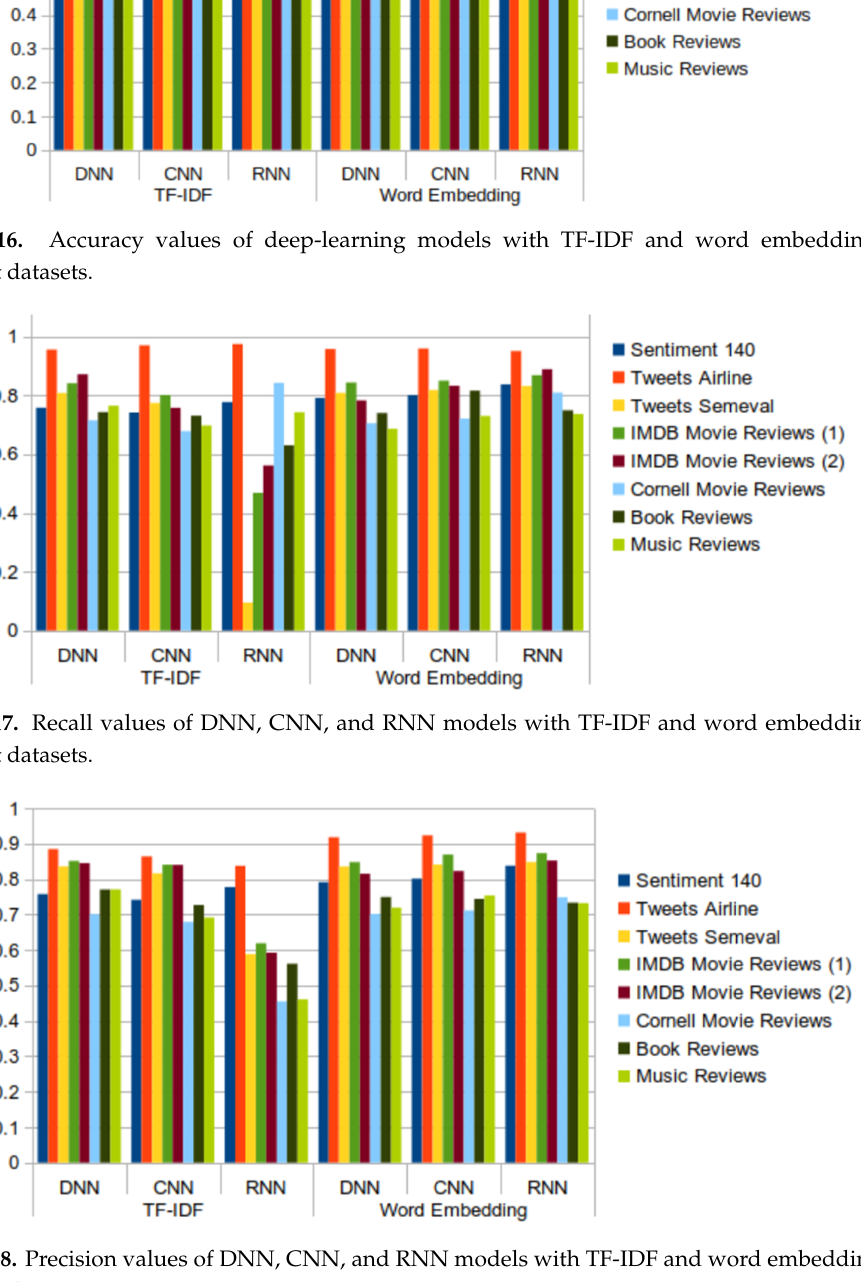
Figure 17. Recall values of DNN, CNN, and RNN models with TF-IDF and word embedding for different datasets. Table 4. The precision comparison for different datasets.